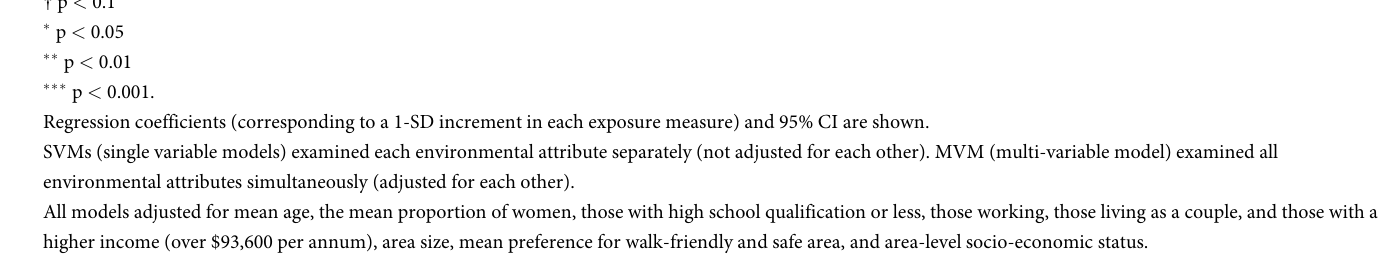
regression coefficients indicating the association of each environmental attribute with walking mobility change at the neighborhood and suburb levels. The risk of multicollinearity was con- sidered low in MVMs, as the variance inflation factor was all below 2 at the neighborhood level and below 5 at the suburb level. Negative coefficients can be interpreted as showing that a 1-SD increment in environmental attribute is associated with more decline in walking mobility score over the study period. At the neighborhood level, it was found that greater land use diversity was associated with less decline in walking mobility, while greater density of social incivilities was associated with more decline in walking mobility score in SVM. In MVM, the association of land use mix and density of social incivilities remained significant. Higher density of bus stops was marginally associated with more decline in walking mobility in SVM, but the associa- tion became non-significant in MVM. At the suburb level analyses, greater land use mix was associated with less decline in walking mobility in both SVM and MVM. Higher residential